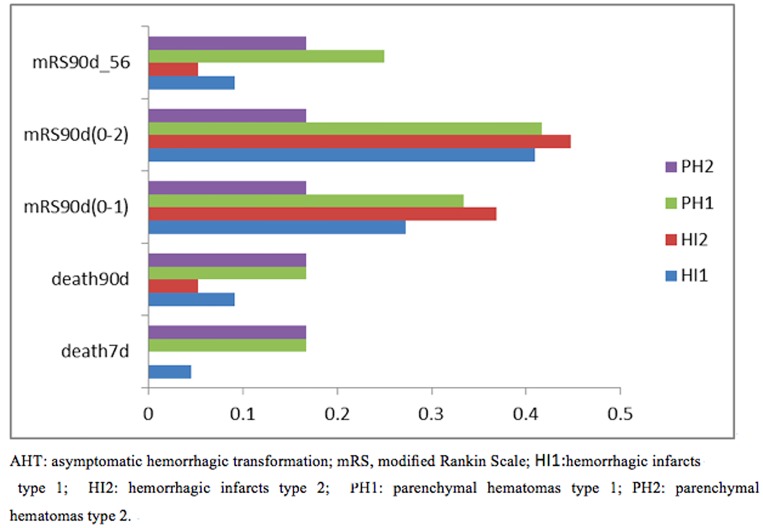
Comparison of function in different subtype of AHT at 7-day and at 90-day in TIMS-china.AHT: asymptomatic hemorrhagic transformation; mRS, modified Rankin Scale; HI1:hemorrhagic infarcts type 1; HI2: hemorrhagic infarcts type 2; PH1: parenchymal hematomas type 1; PH2: parenchymal hematomas type 2.